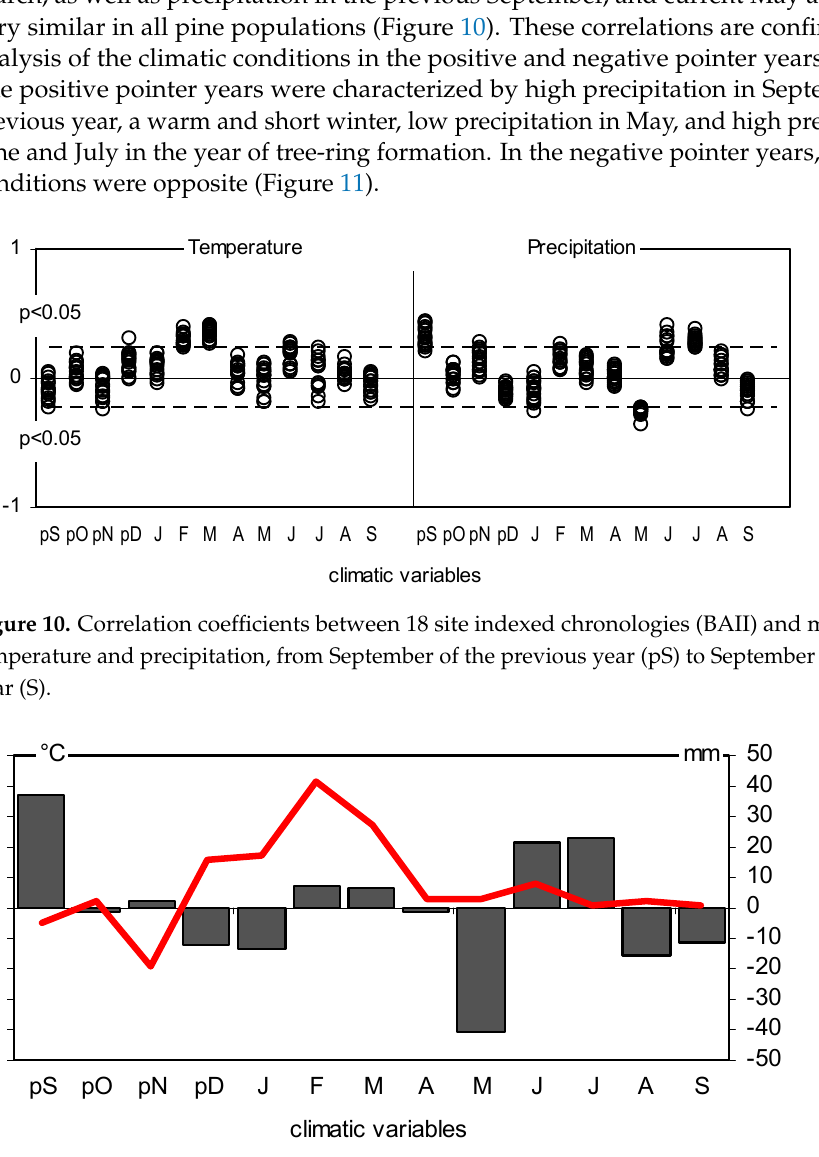
Figure 9. Regional chronology of IT indices and positive (white dots) and negative (black dots) pointer years.